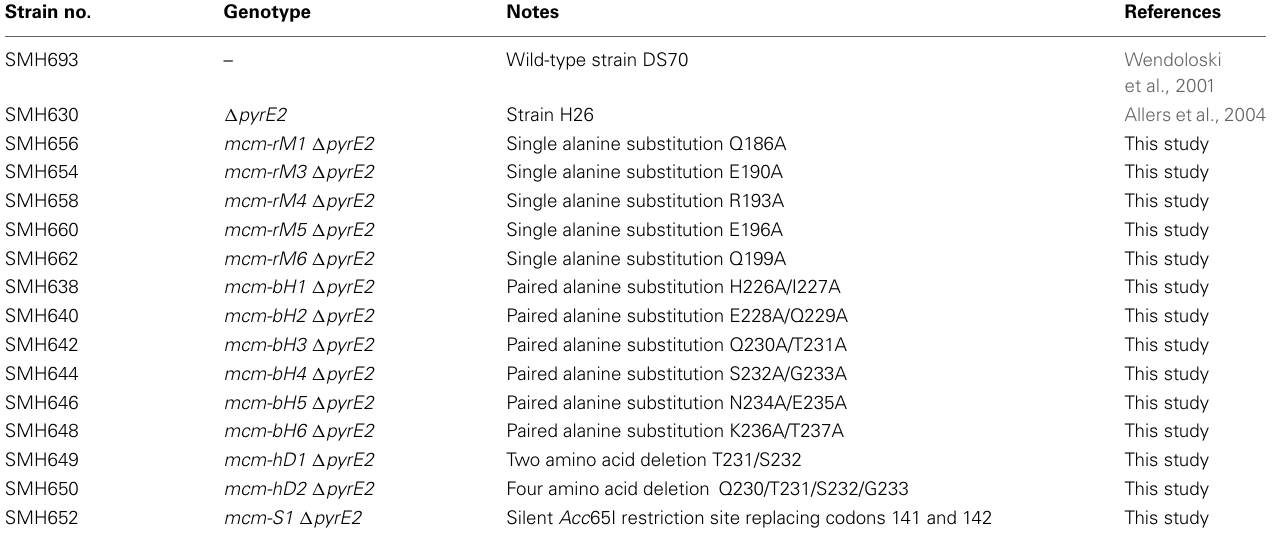
Table 2 | Haloferax volcanii strains used in this study. Strain